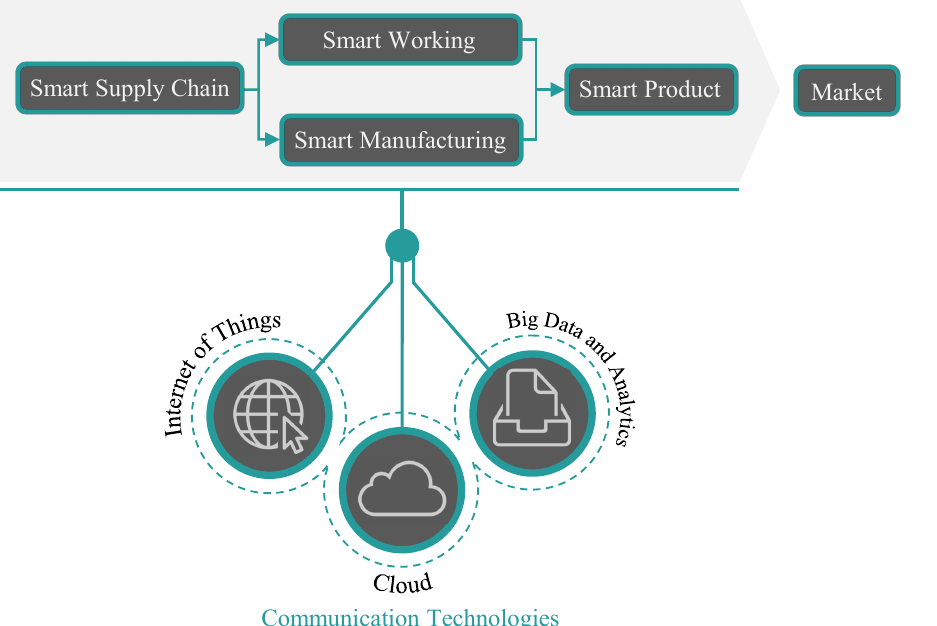
Figure 1. Framework representing the flow and correlation between the categories of Industry 4.0